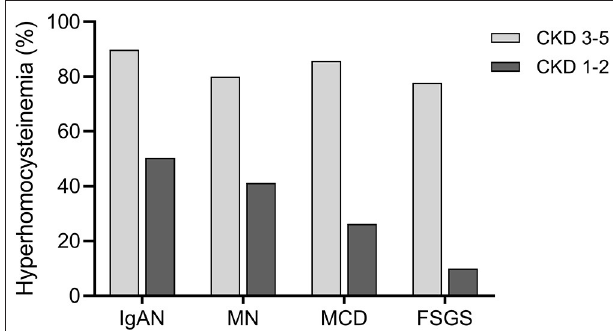
FIGURE 1 | Prevalence of hyperhomocysteinemia (HHcy) in different CKD stages in primary glomerular diseases. In patients with CKD stages 3–5, the prevalence of HHcy was 89.8% (88/98), 80.0% (36/45), 85.7% (12/14), and 77.8% (7/9) in IgAN, MN, MCD, and FSGS, respectively. In patients with